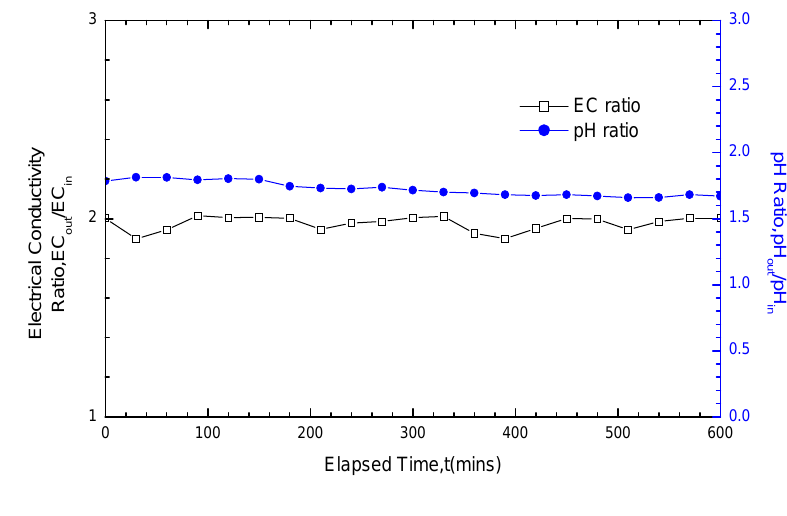
Figure 13. pH ratio and EC (electrical conductivity) ratio results for GCL specimens soaked with 50 mM NaCl solution for five days and permeated with the same solution after